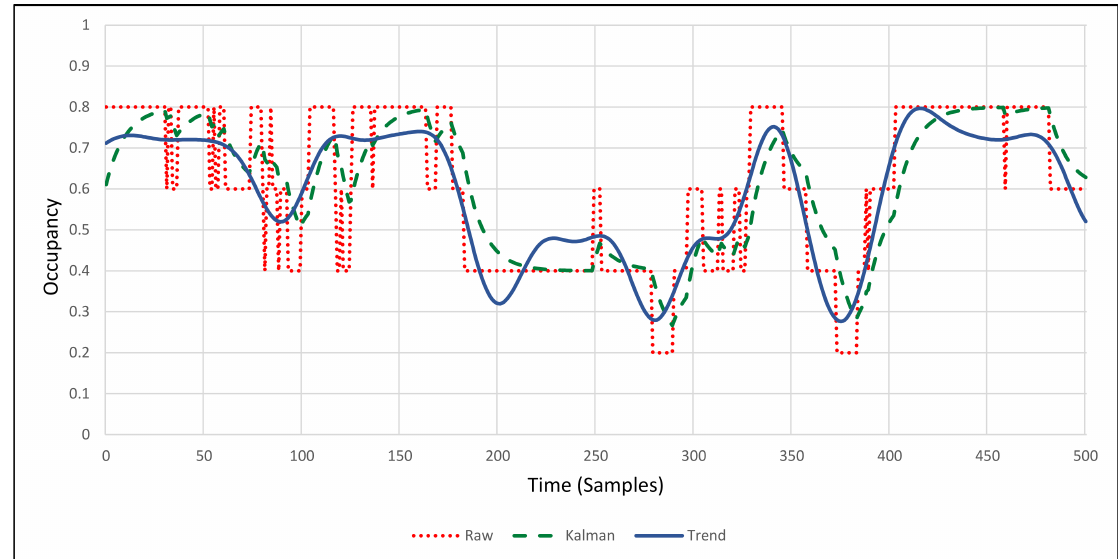
Figure 7. Comparison among raw data (red), Support Vector Machine (SVR) trend (blue) and Kalman online estimates